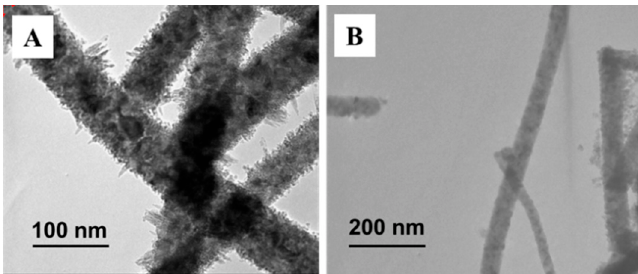
Figure 7. TEM images of ( A ) anatase core@rutile shell TiO 2 nanofibers; ( B ) rutile core@anatase shell TiO 2 nanofibers, respectively.